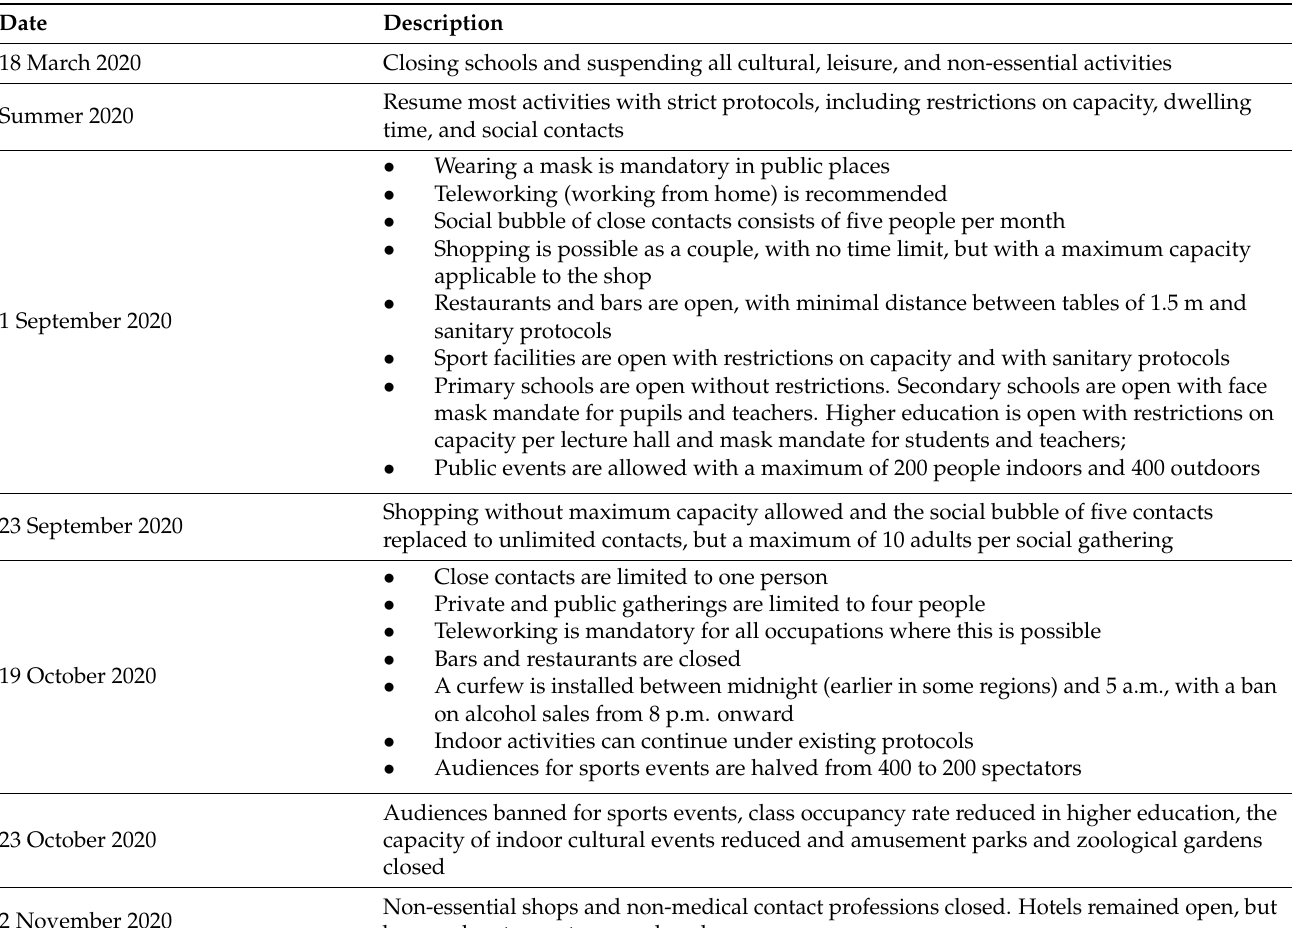
Table 1. Overview of non-pharmaceutical interventions in